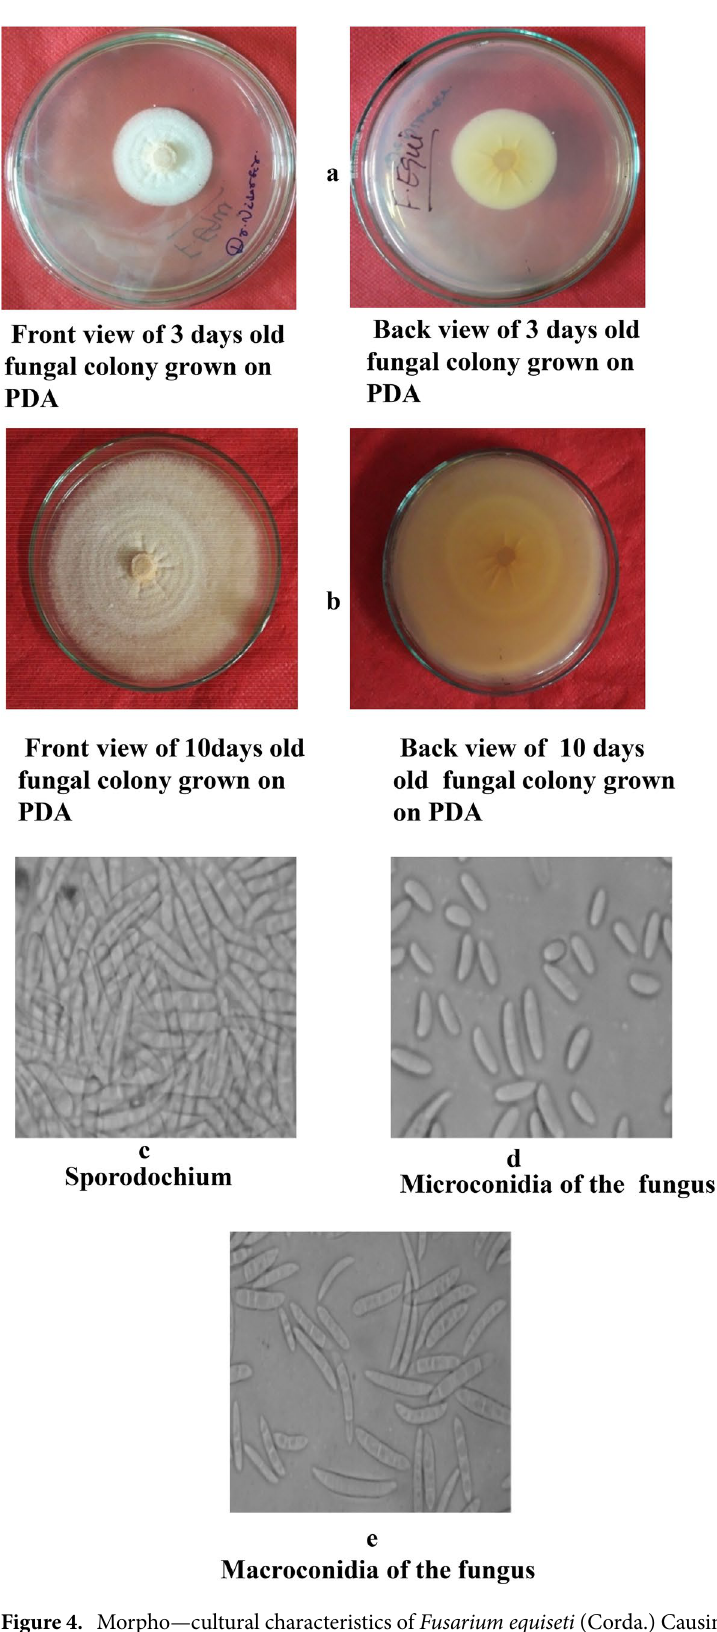
Figure 4. Morpho—cultural characteristics of Fusarium equiseti (Corda.) Causing chilli